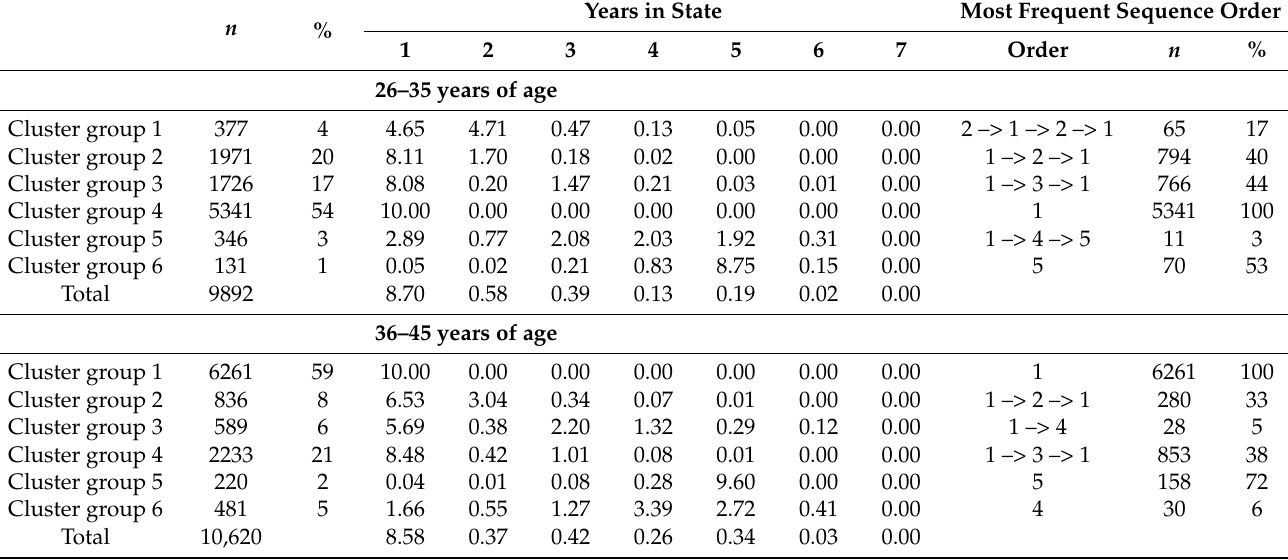
Table 2. Frequencies of sequence groups and years in